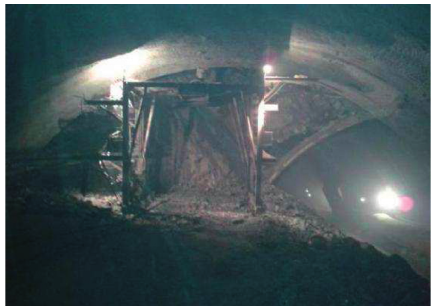
Figure 7: Field experiment diagram of the reverse bench excavation project.